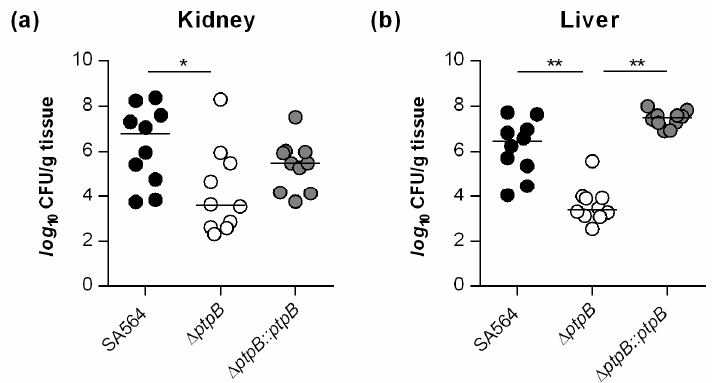
Figure 2. PtpB contributes to infectivity of S. aureus SA564 in a murine abscess model. C57BL/6N mice were infected via retroorbital injection with 1 × 10 7 cells of S. aureus strain SA564 (black symbols), SA564 ∆ ptpB (white symbols), and the cis -complemented derivative SA564 ∆ ptpB::ptpB (gray symbols), respectively ( n = 10 per group). Mice were euthanized 4 days post-infection, livers and kidneys were removed and homogenized in PBS, and serial dilutions of the homogenates plated on sheep blood agar plates to determine the bacterial loads in kidney ( a ) and liver ( b ) organs. Each symbol represents an individual mouse. Horizontal bars indicate the median of all observations.